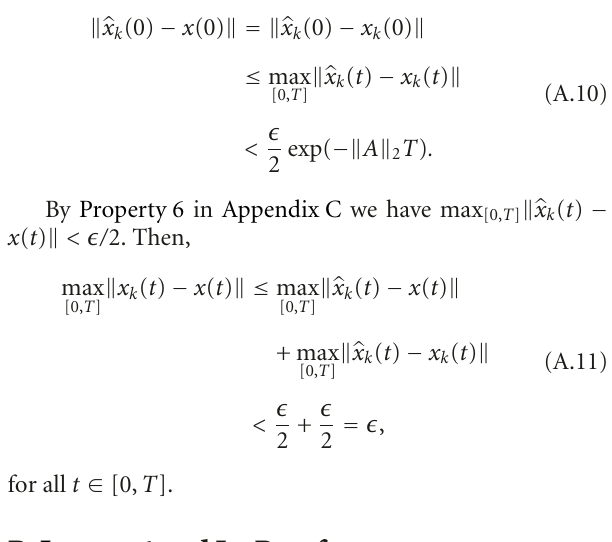
for t ≥ 0, where G ( x ) = ( g ( x 1 ), g ( x 2 ), ... , g ( x n )) (cid:3) , x ∈ R n , and g ( · ) is given in